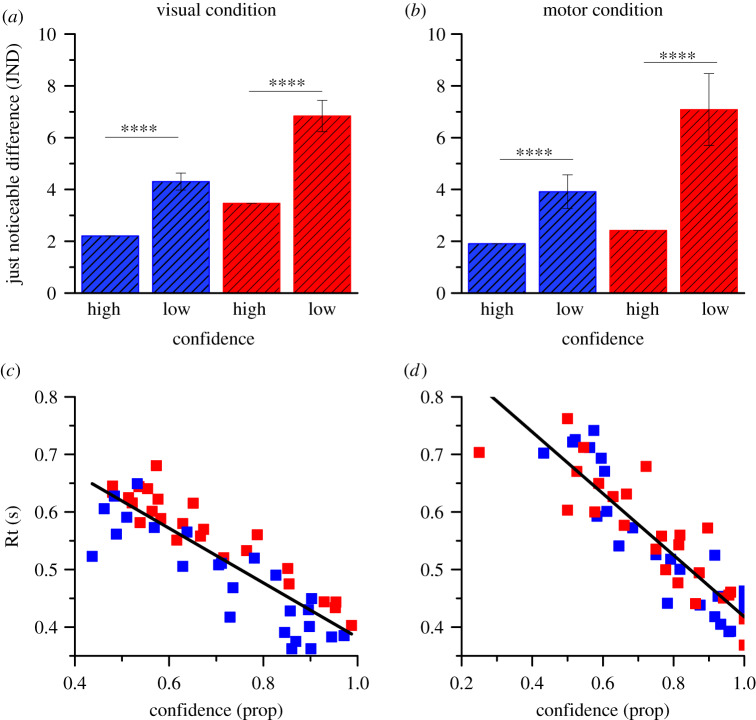
Bar graphs show precision for numerosity discrimination in the high or low confidence trials. In blue, data for baseline (or slow tapping) and red data for adaptation to high (or fast tapping) for visual and motor adaptation. (c,d) Reaction times (Rt; averaged over trials and subjects) as a function of confidence (averaged over trials and subjects) for the two adaptation conditions. Black lines represent the best-fitting linear regressions ((c) visual adaptation: R2 = 0.76; (d) motor adaptation: R2 = 0.79). Error bar represents ±1 s.e.m., ****p < 0.0001. (Online version in colour.)